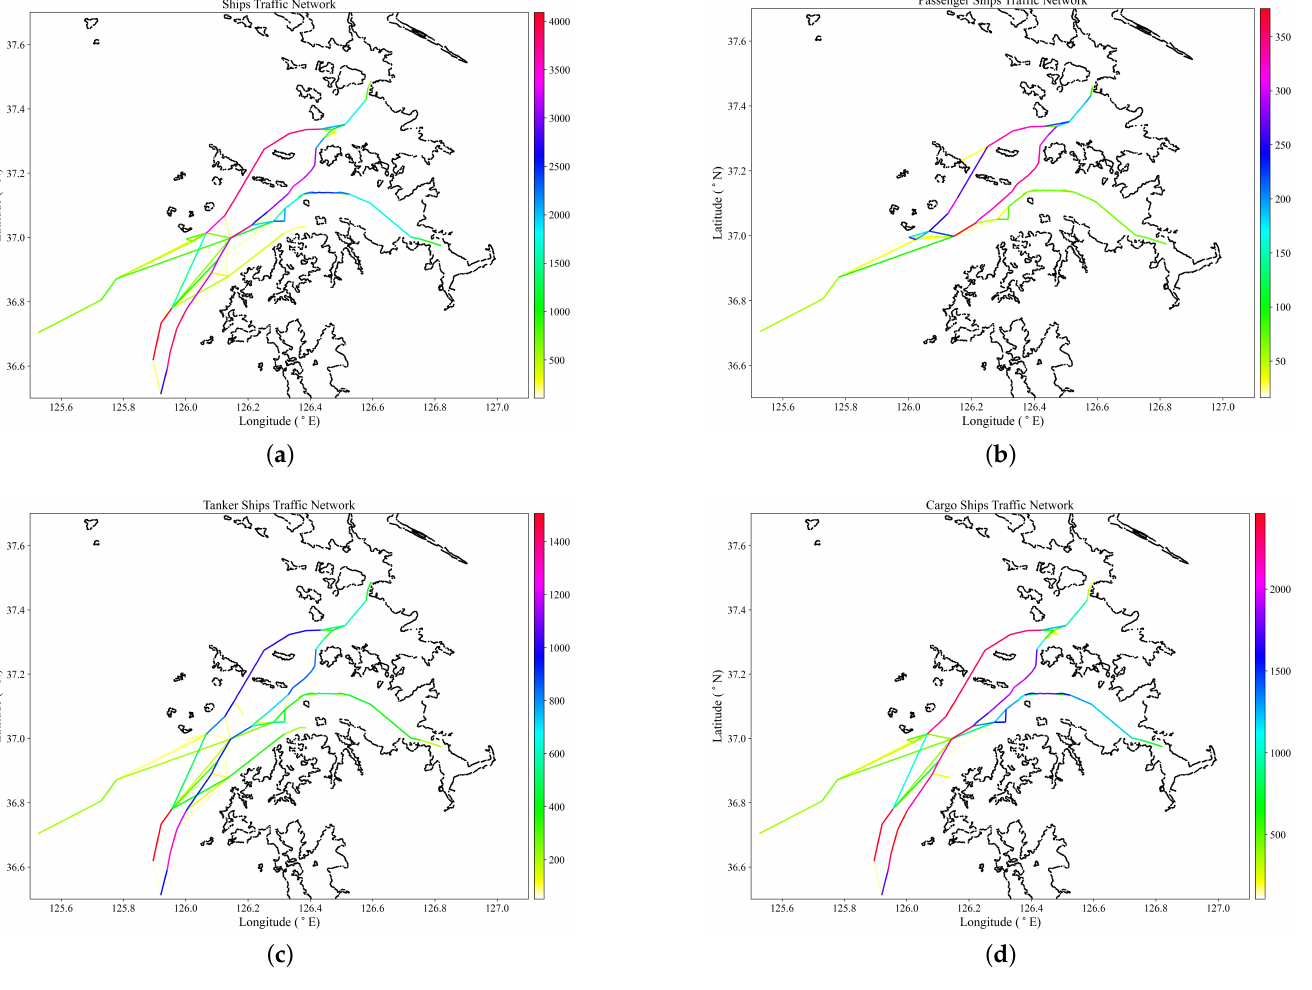
Figure 8. Maritime traffic network by ship type. ( a ) Traffic network for all ships. ( b ) Passenger ships traffic network. ( c ) Tanker ships traffic network. ( d ) Cargo ships traffic network. The color bars in the sub-figures represent ship traffic by MMSI count, with red representing the highest value and white representing the lowest value in the illustrated category. Figure 8a shows a maritime traffic network for all ships. It is observed that the highest ship traffic is in Heuk-do TSS at above 4000, which is the outbound traffic, with a majority in the region of above 3000 destined to Incheon port from inbound Heuk-do TSS via Dong-sudo to Incheon port, 1500 to 1000 in Pyeongtaek port, and a minority of below 500 in Daesan port. Passenger ship traffic in Figure 8b operates to and from the Incheon passenger terminal, Pyeongtaek passenger terminal, and Deokjeok Island. The highest passenger ship traffic is observed at Seo-sudo and Dong-sudo lanes in the Incheon port, with the lowest traffic from Deokjeok Island. Passenger ships outbound and inbound traffic are observed from the west of the Incheon port approach area. In Figure 8c, tanker ship traffic is highest at Heuk-do TSS outbound lane, above 1400, with a large portion of tanker traffic observed to and from Incheon port and a minority of traffic, below 600, at Pyeongtaek and Daesan port. In Figure 8d, cargo ship traffic is highest between Heuk-do TSS and Incheon port, with Pyeongtaek port ranking second and being the only other port with cargo ship traffic. Most cargo inbound and outbound traffic in the Incheon port approach is at Heuk-do